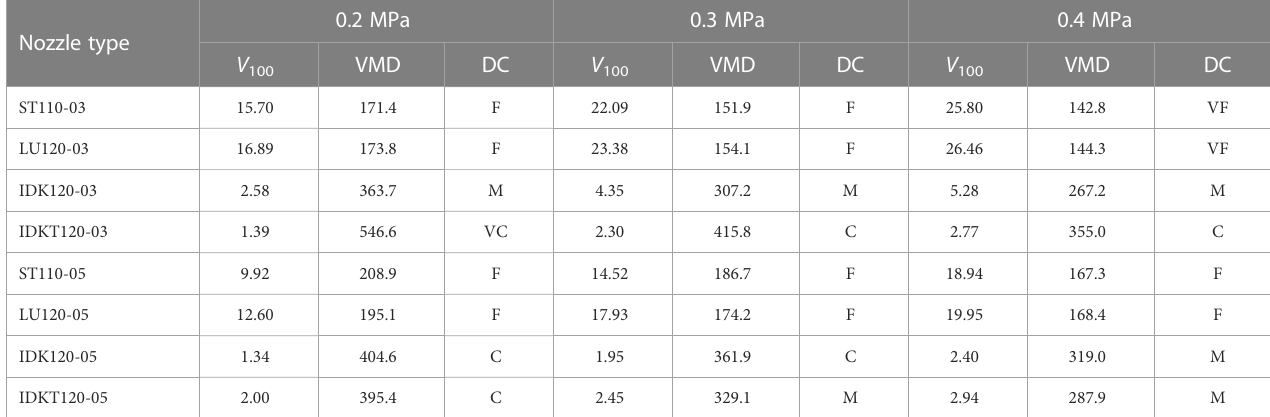
Minimum wind velocity (m/s)